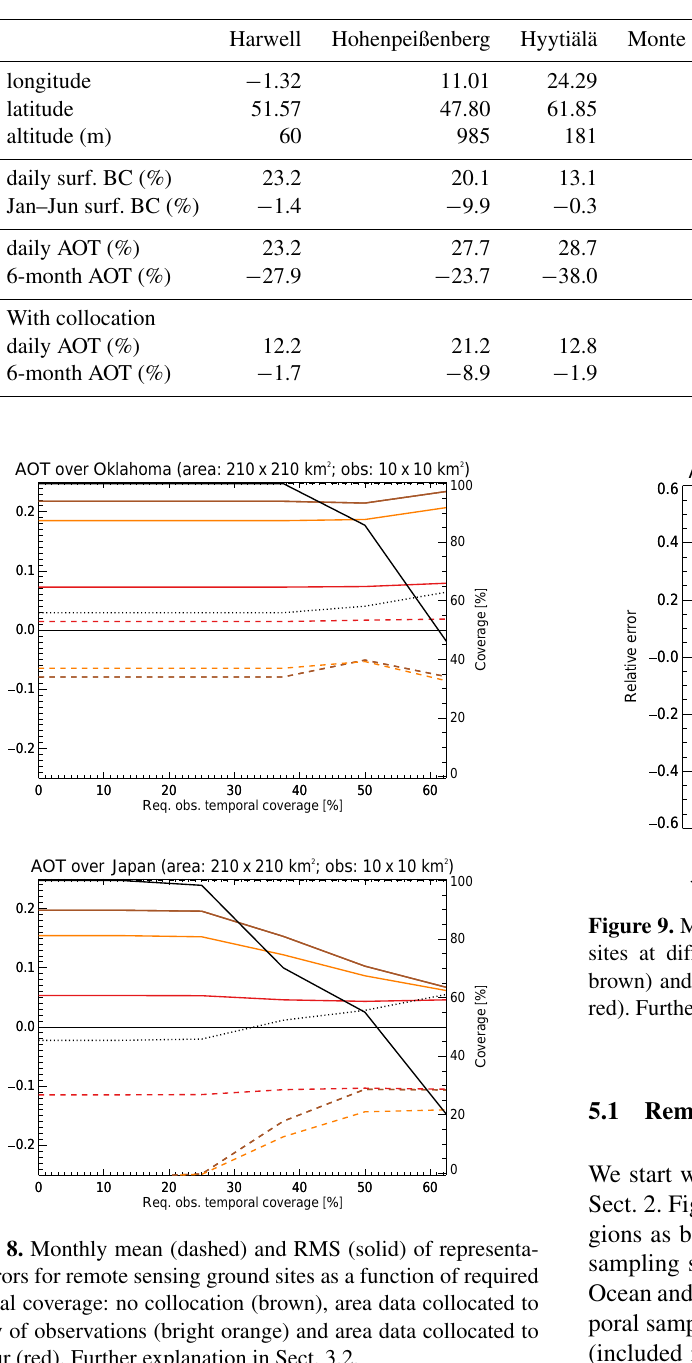
Table 3. Semi-annual relative representation errors for ACTRIS sites.